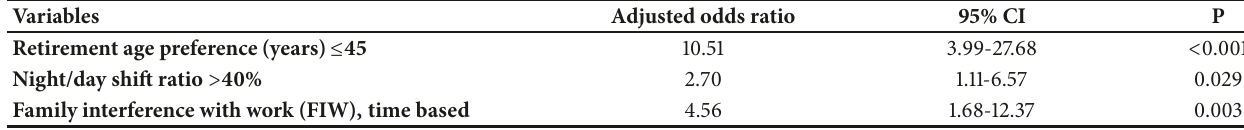
Table 6: Logistic regression analysis of factors associated with intention to leave (ITL).